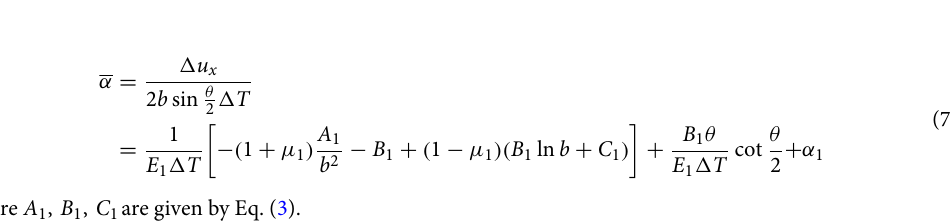
Figure 2. Deformations at both ends of the curved